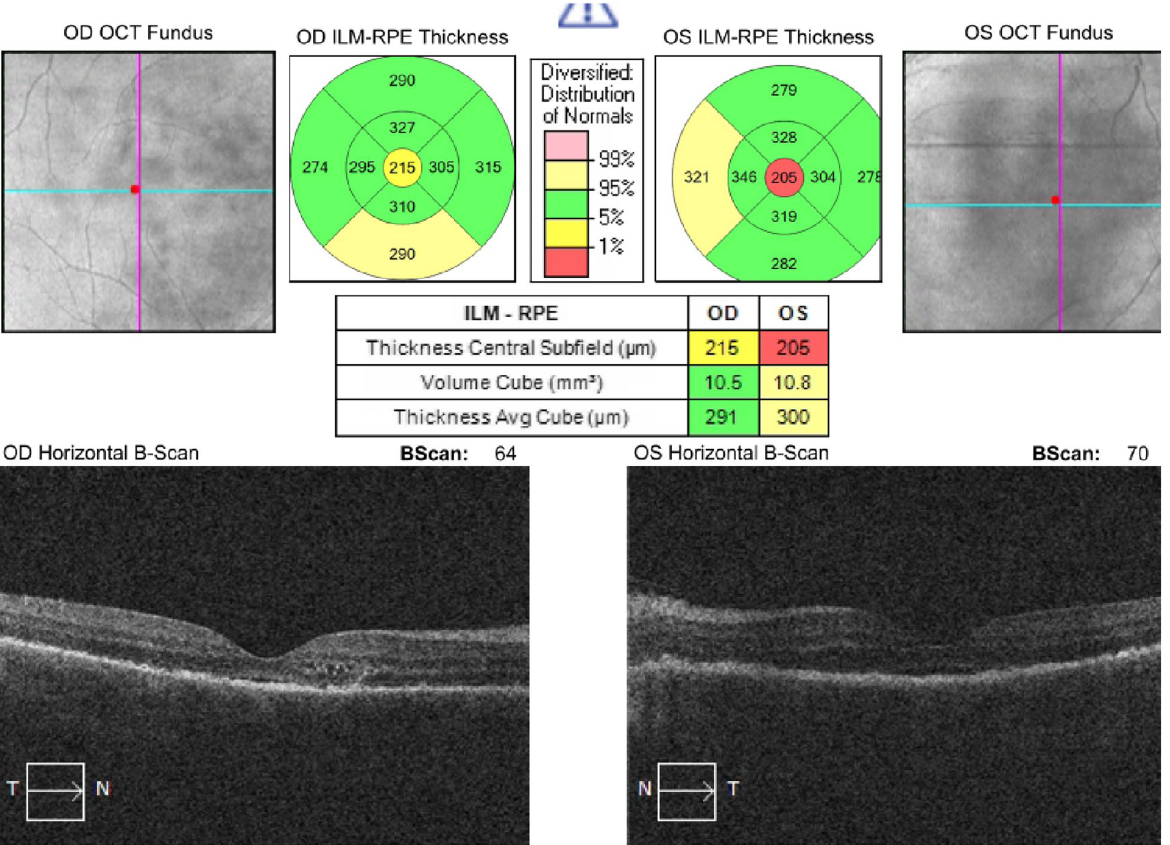
Fig. 5 09.09.2021: BCVA